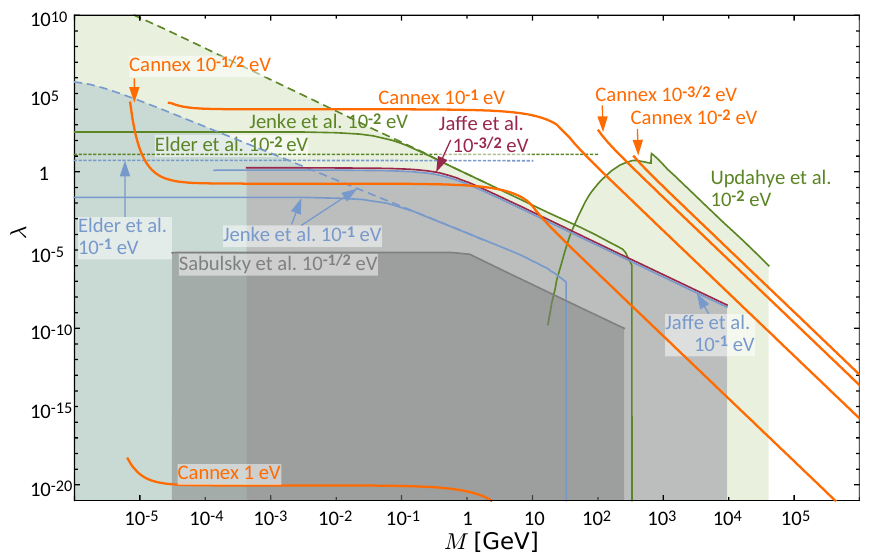
Figure 12. Limits on the symmetron parameter λ as a function of M at several fixed values of µ . Existing limits from atom interferometry (Jaffe et al. [239], 95% C.L.; Sabulsky et al. [240], 90% C.L.), (prospective) Casimir experiments (Elder et al. [209], 95% C.L.), and torsion balance experiments (Updahye et al. [244], no C.L. given). Limits for equal µ are shaded in blue: 10 − 2 eV, red: 10 − 3/2 eV, green: 10 − 1 eV, and gray: 10 − 1/2 eV. Prospective limits for C ANNEX (orange, 90% C.L.) are computed for a separation of a = 10µm, based on the analysis of systematic effects in Section 5, and include solutions for ‘broken and unbroken phase parameter ranges’